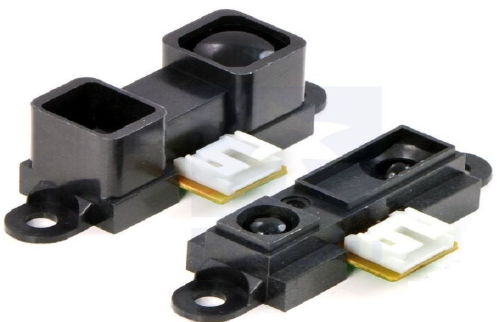
Figure 4. Lightweight, low-cost range sensors suitable for small movement detection. Photos courtesy of Sparkfun Electronics [31].